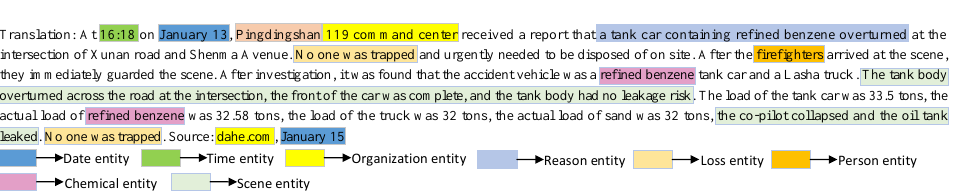
Figure 10. Process of labeling data on Brat